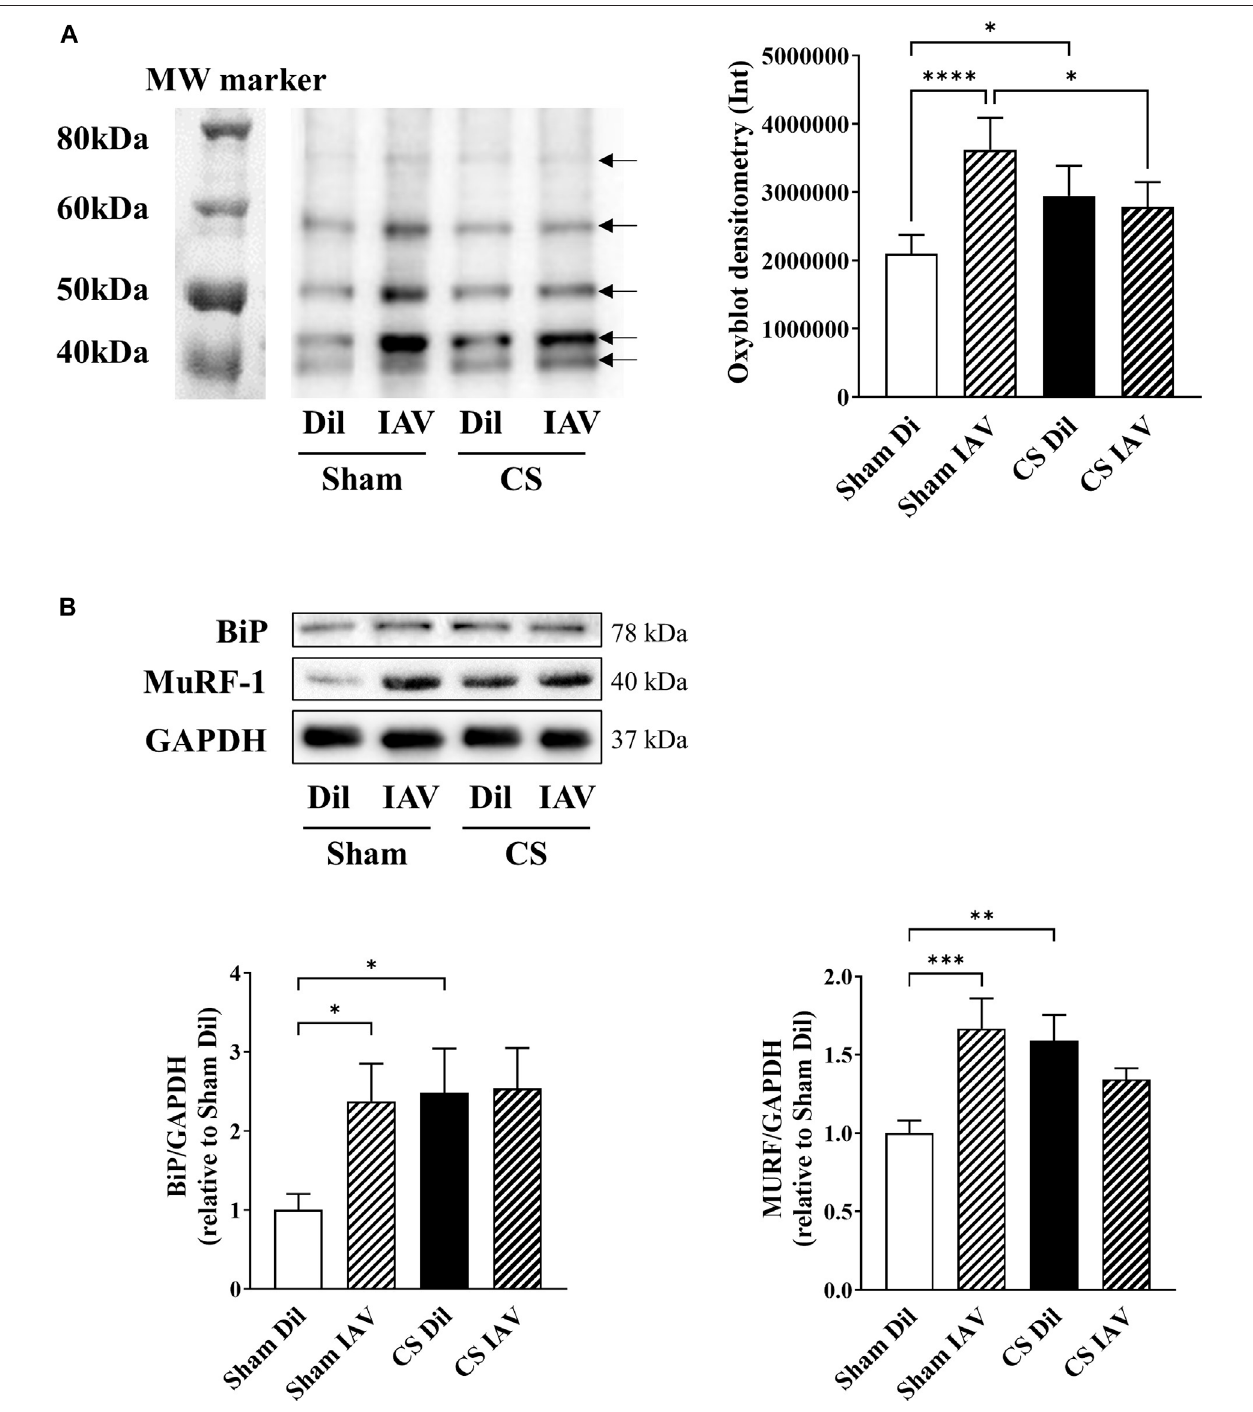
FIGURE 5 | Effect of CS exposure and in fl uenza A virus (IAV) infection on oxidative stress and myogenic signaling in tibialis anterior (TA) of mice. Total protein carbonylation was measured using (A) Oxyblot staining and subsequent densitometry analysis on muscle homogenates of CS-exposed and Sham mice infected with IAV. Bands indicated by black arrows in densitometry were measured and added up for analysis. (B) Western blot images and quantitative densitometry analysis of BiP and MURF. Data shown as mean +SEM ( n = 8 per group). * p < 0.05, ** p < 0.01, *** p < 0.001, **** p < 0.0001.